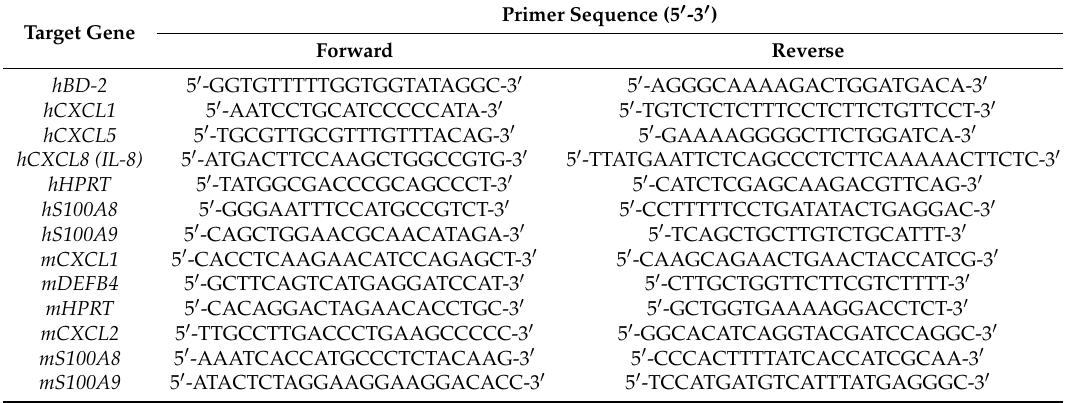
Table 1. Sequences of primers used for quantitative real-time polymerase chain reaction